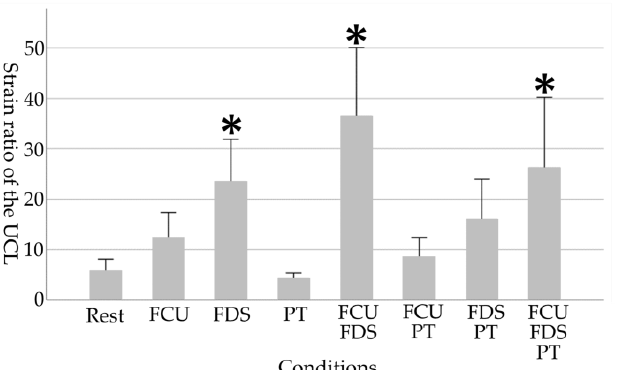
Figure 4. Changes in UCL due to selective contraction of the FPMs. A higher value in strain ratio indicates harder (stiffer) tissue. Asterisks indicate significant differences compared to the resting condition ( p < 0.05). Error bars in the graph are standard errors. UCL, ulnar collateral ligament; FCU, flexor carpi ulnaris; FDS, flexor digitorum superficialis; PT, pronator teres.